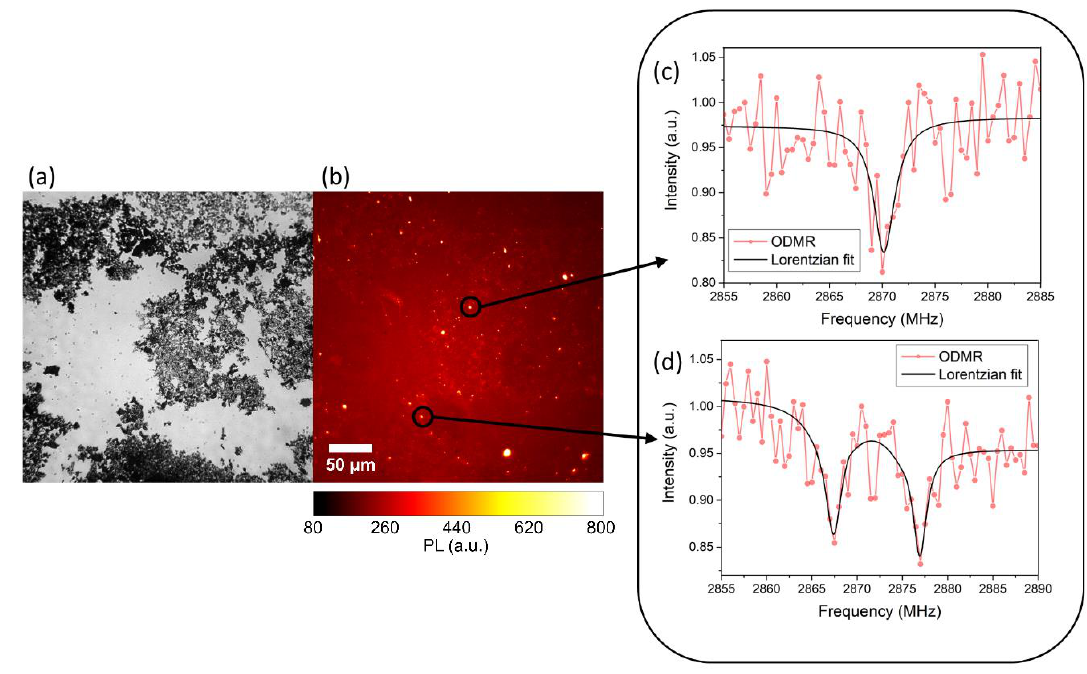
Figure 8. ( a ) Wide field optical image and ( b ) relative photoluminescence (PL) image. ( c , d ) Typical ODMR spectra obtained from the bright spot of ( b ), confirming the Nitrogen-Vacancy (NV) origin of the collected PL. The intensity reduction at 2.87 GHz is evident in ( c ), while in ( d ) a double resonance is observed due to strain of the NDs hosting the NV centers and removing the degeneracy of the m s = ± 1 states. Reproduced with permission from [65], Elsevier, 2019.